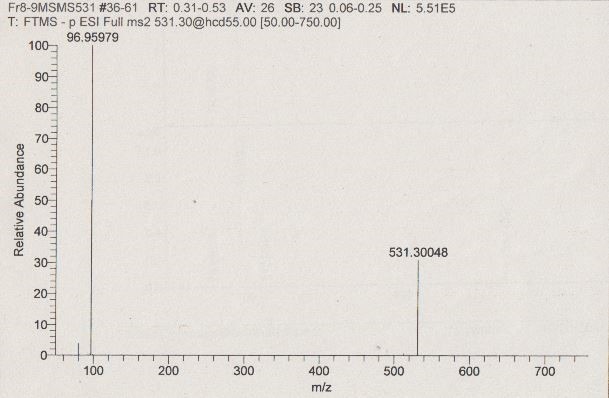
MS/MS of m/z =531.3 in fraction “8”.Negative ionization MS/MS of m/z 531 [M– H]–:96.95979 (HSO4–calc=m/z 96.96010, ∆ = –3.2ppm), which indicated the presence of a sulfate group in m/z 531.30048 [M– H]–.